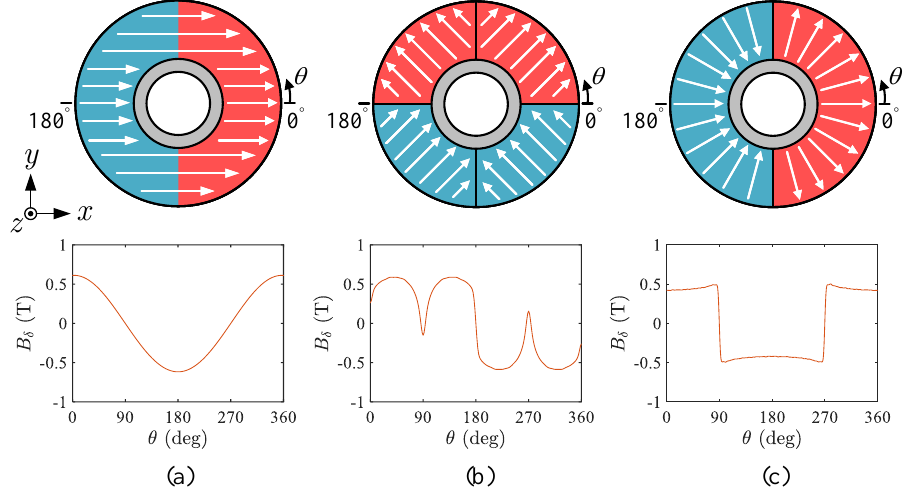
Figure 3. Two-pole rotors with different magnetization methods. ( a ) Sinusoidal magnetization. ( b ) Diametric magnetization. ( c ) Radial